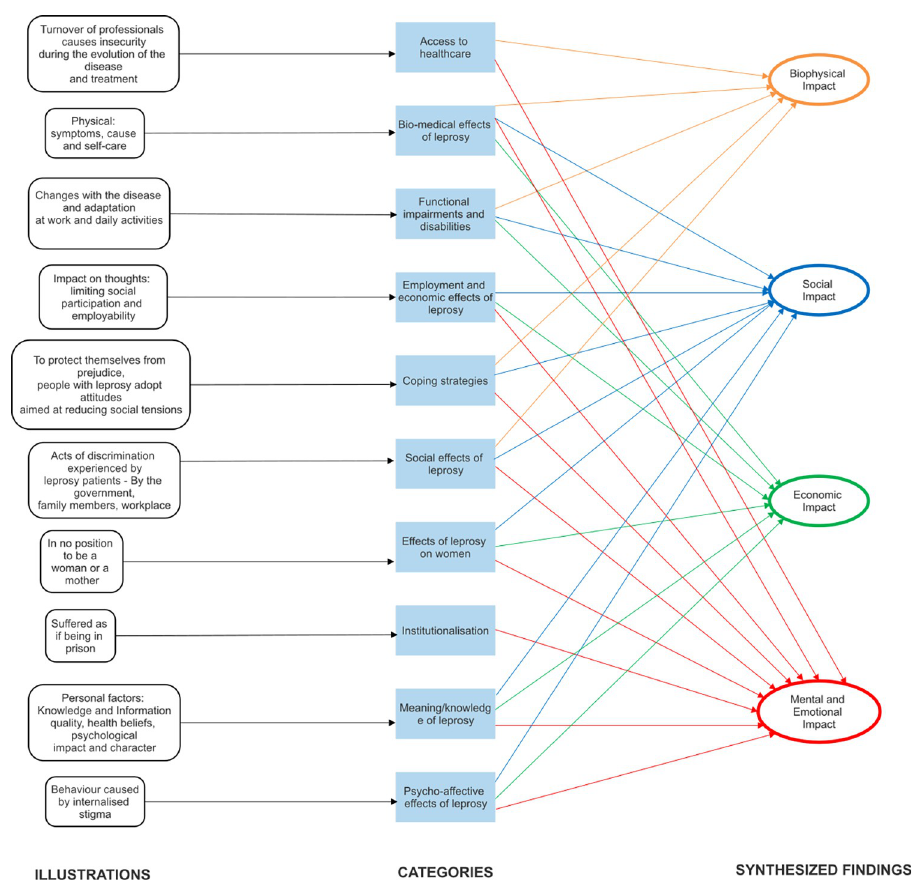
Fig 2. The effects of leprosy on the lives of the leprosy-affected